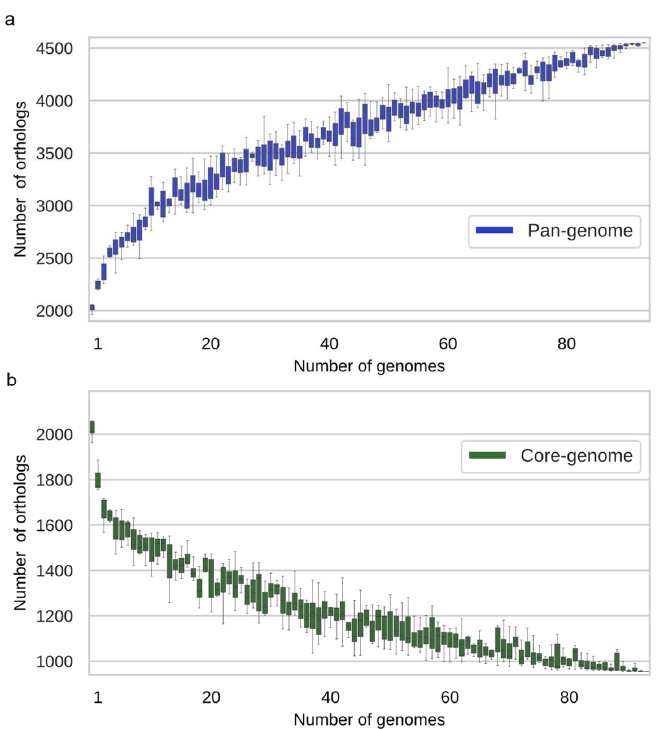
Figure 1. Pangenome and core-genome of 94 X. fastidiosa strains. Pangenome ( a ) and core genome ( b ) curves. Each boxplot represents the distribution of the number of orthologous CDSs clusters added (pangenome) or in common (core genome) with the addition of new genomes.